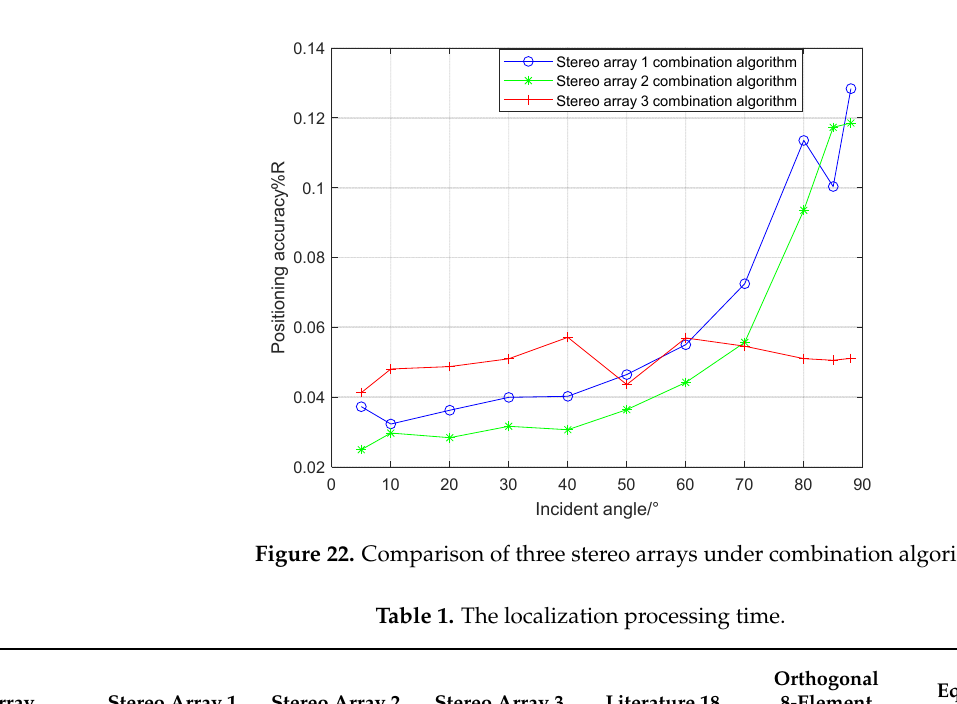
Figure 21. Comparison between combination algorithm and precombination algorithm for stereo array 3.